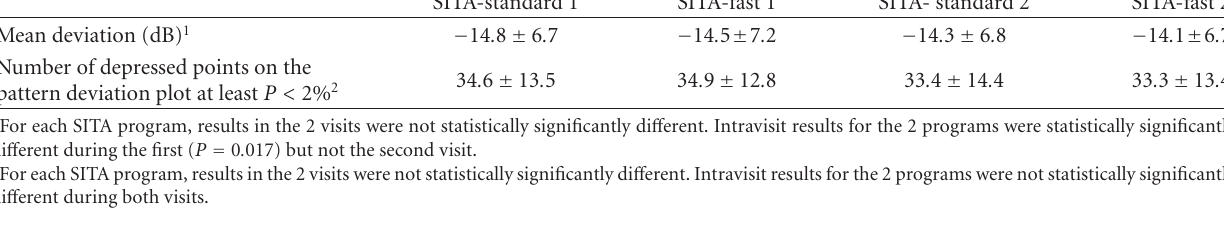
Table 2: Reliability parameters (mean ± SD) for each of the 10-2 tests, using 2 programs (SITA-standard and SITA-fast) in 2 separate visits. There was no statistically significant di ff erence in any parameter for all test